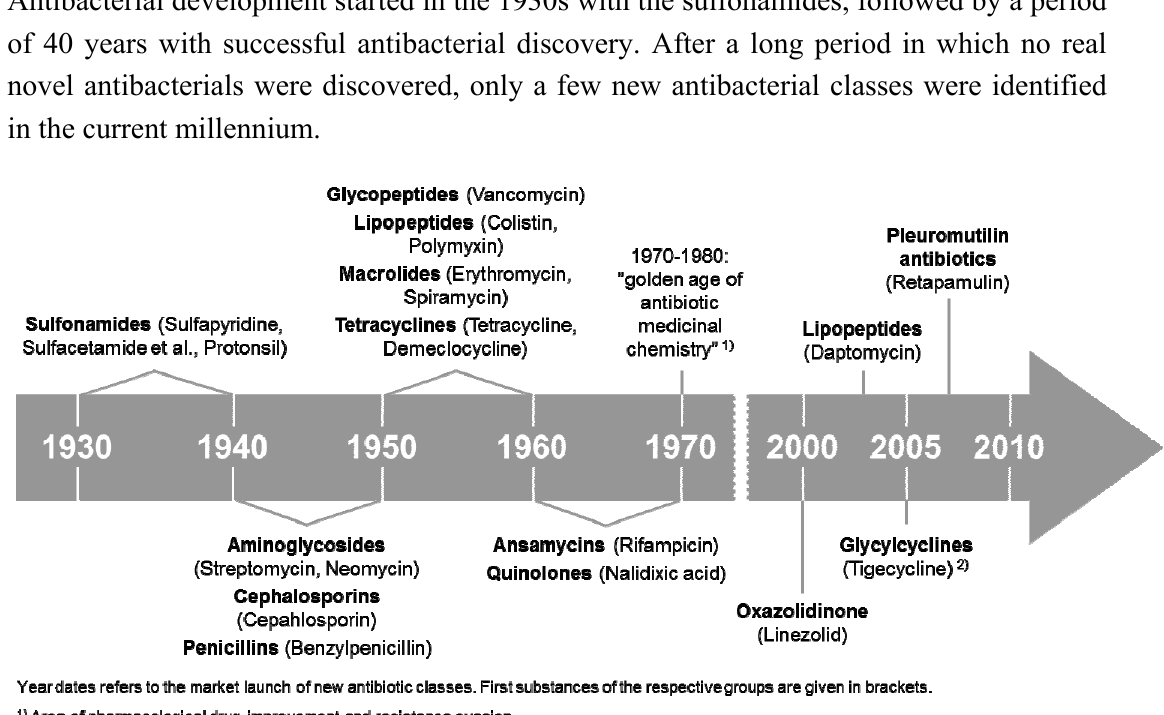
Figure 2. The timeline of antibacterial development modified from Wright